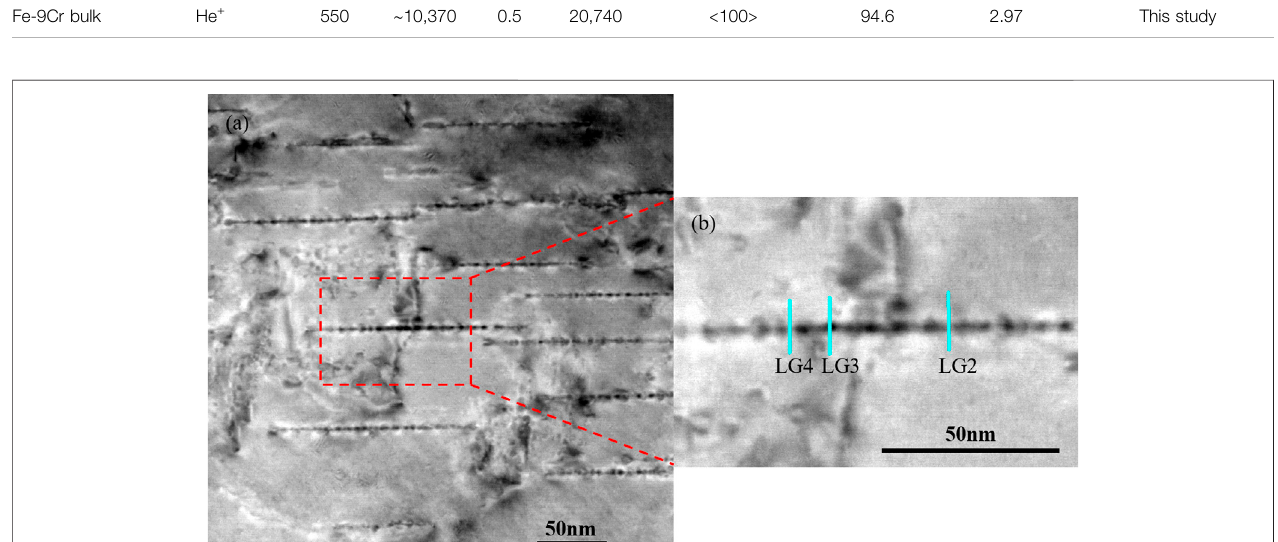
FIGURE 9 | The high-angle annular dark- fi eld (HAADF) image of bubble-loop complexes taken on < 110 > zone axis; the blue lines represent the traces of the line scan for EDS measurement.